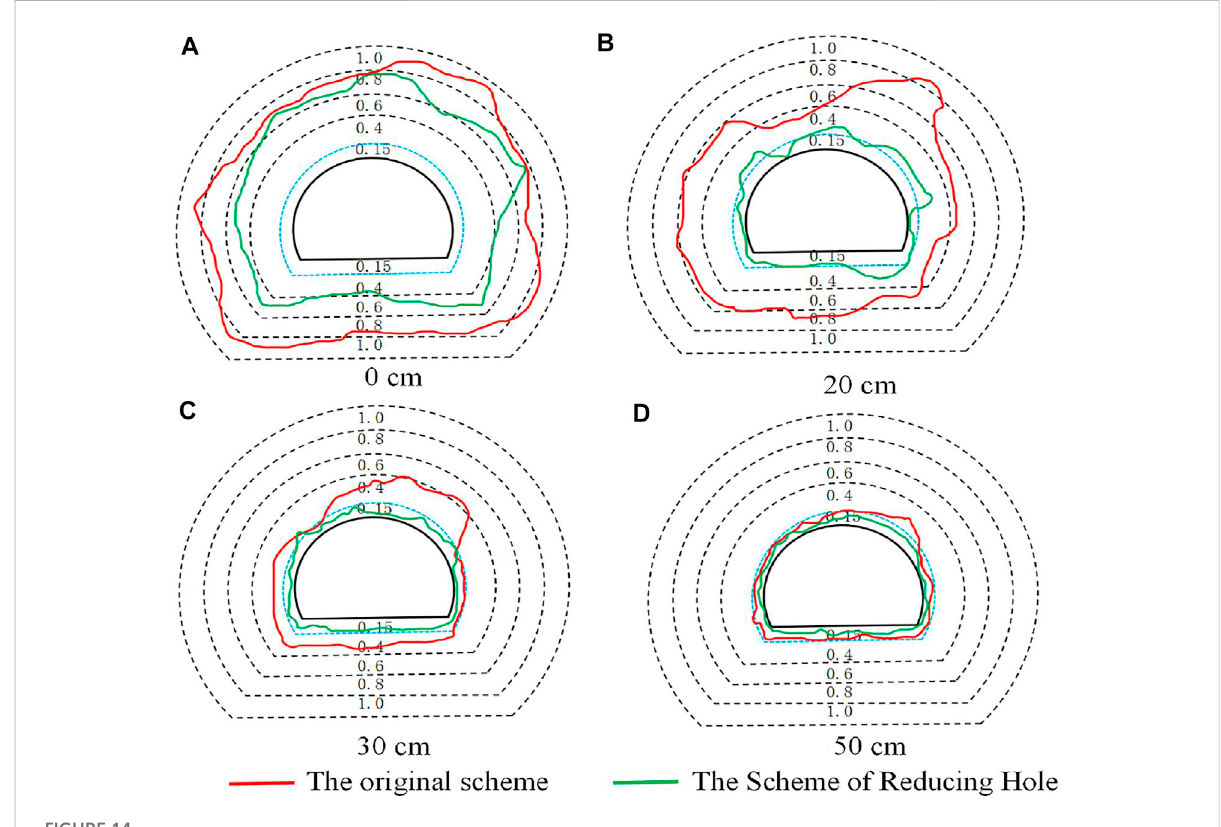
FIGURE 14 Different position damage peak